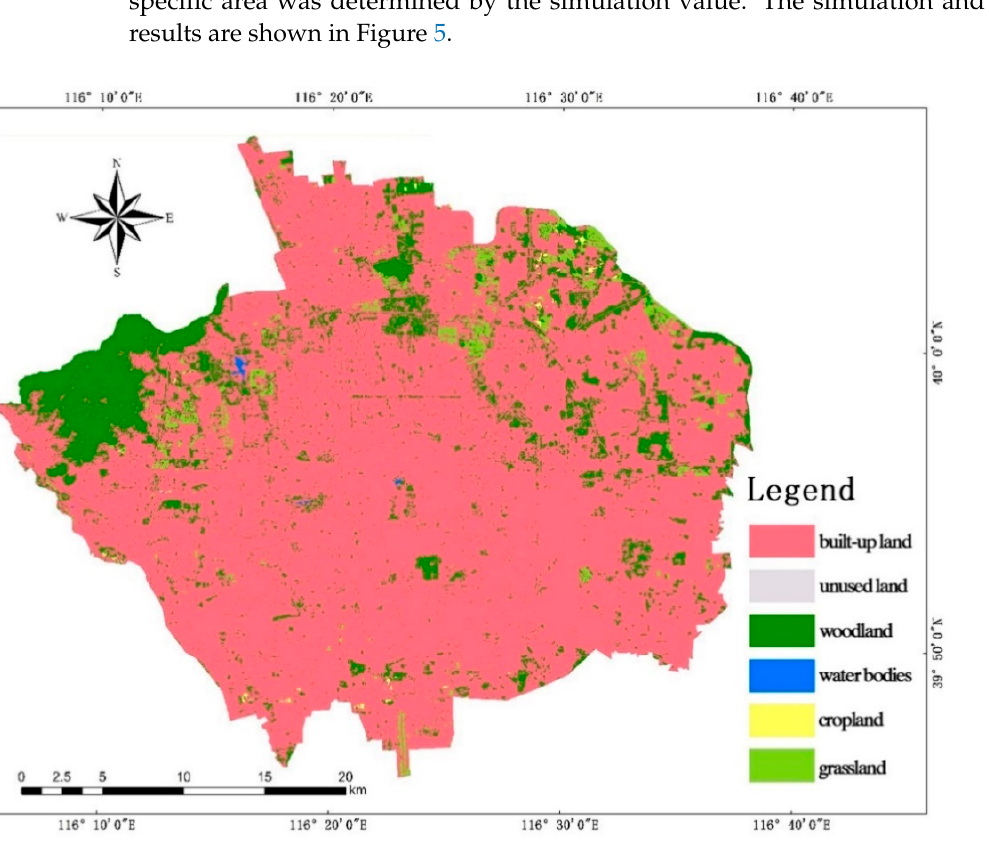
Figure 5. Results of the CA Model Simulation of Green Spaces in Beijing’s Central District in 2035.